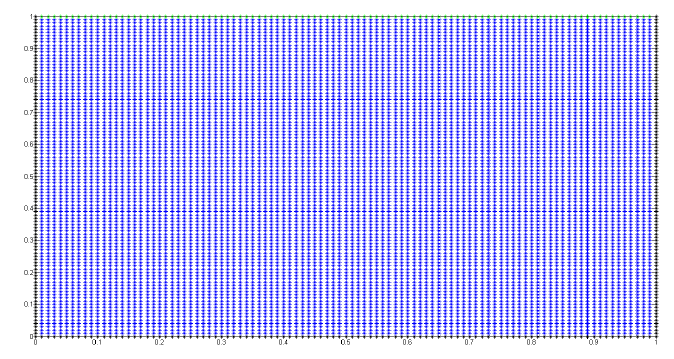
Figure 4. Second cloud of points for the 2D examples (Cloud